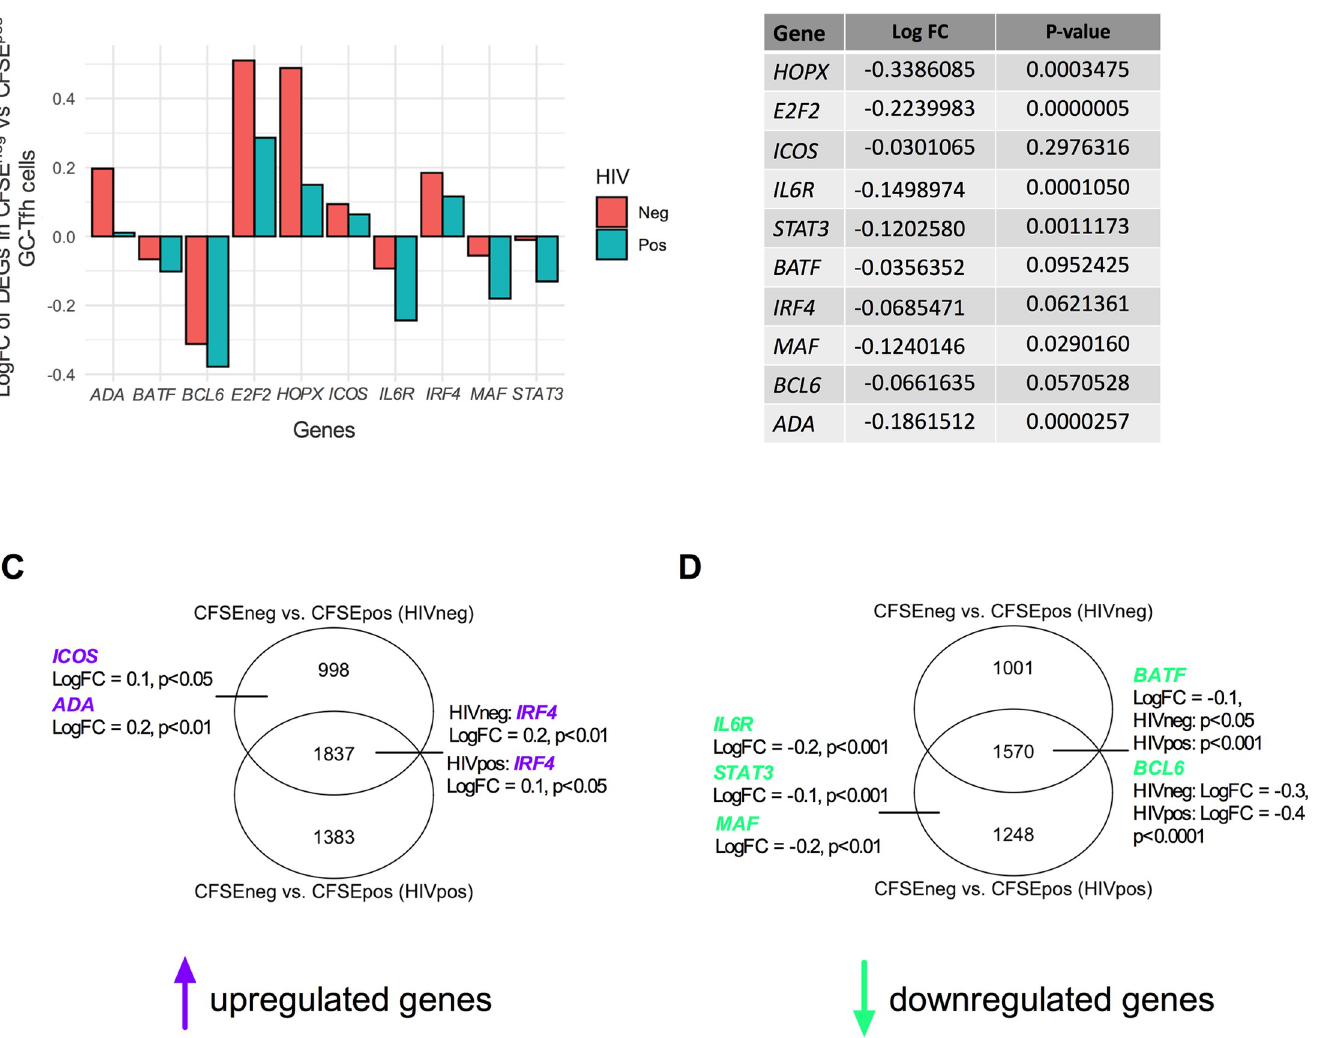
PLOS Pathogens| https://doi.org/10.1371/journal.ppat.1009732 July 19,